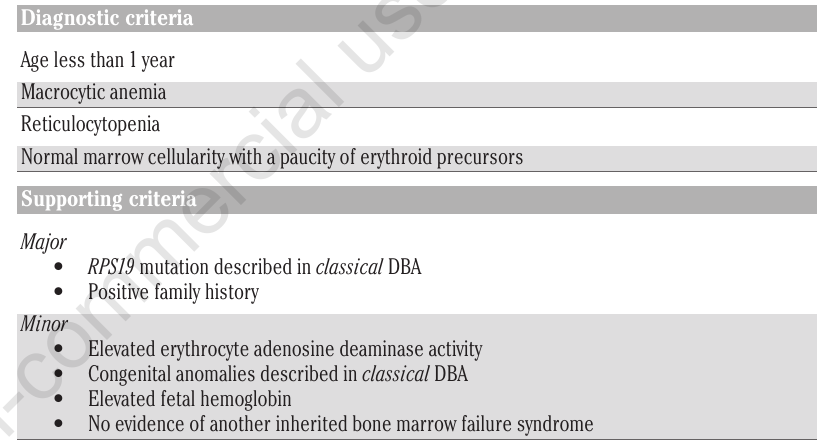
Table 1. Diagnosis of Diamond-Blackfan